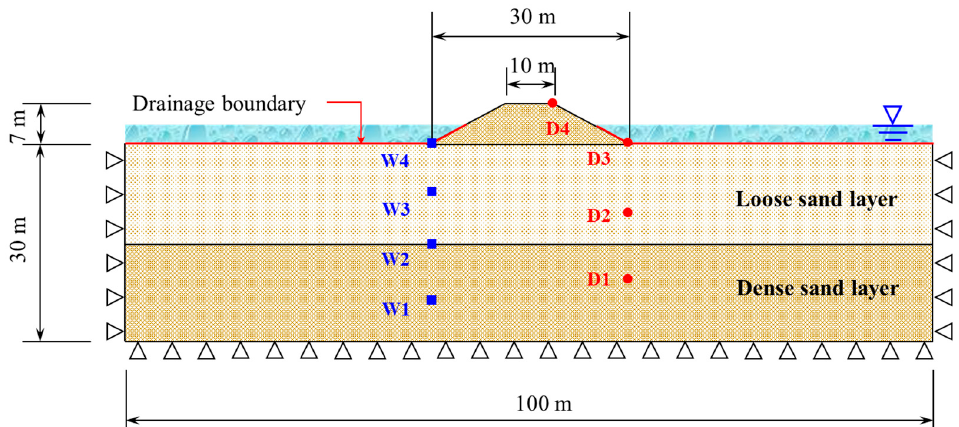
Figure 8. Computational model of 2D liquefiable site.